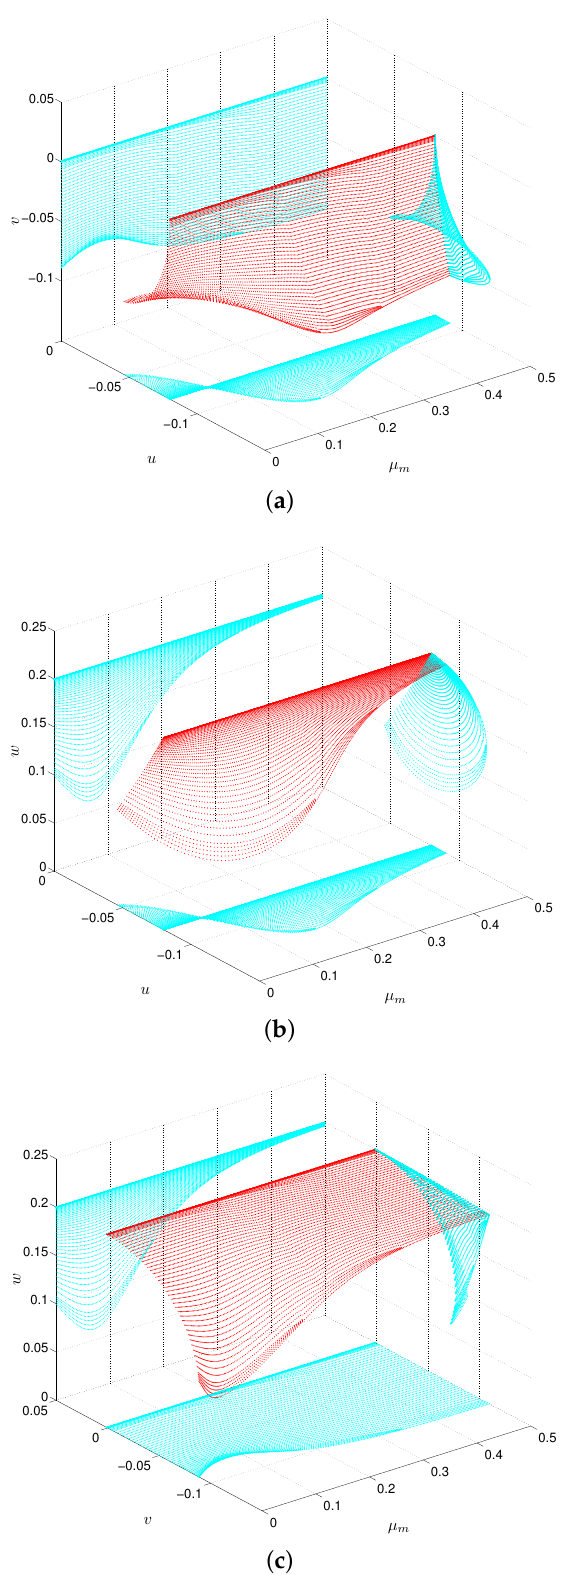
Figure 7. ( a – c ) Bifurcation diagrams of the mass parameter µ m in the frames µ m uv , µ m uw and µ m vw , respectively, when κ = 1, q 1 = 0.9988, q 2 = 0.9985, α 1 = 0.024, α 2 = 0.02, α = 1.001, β =